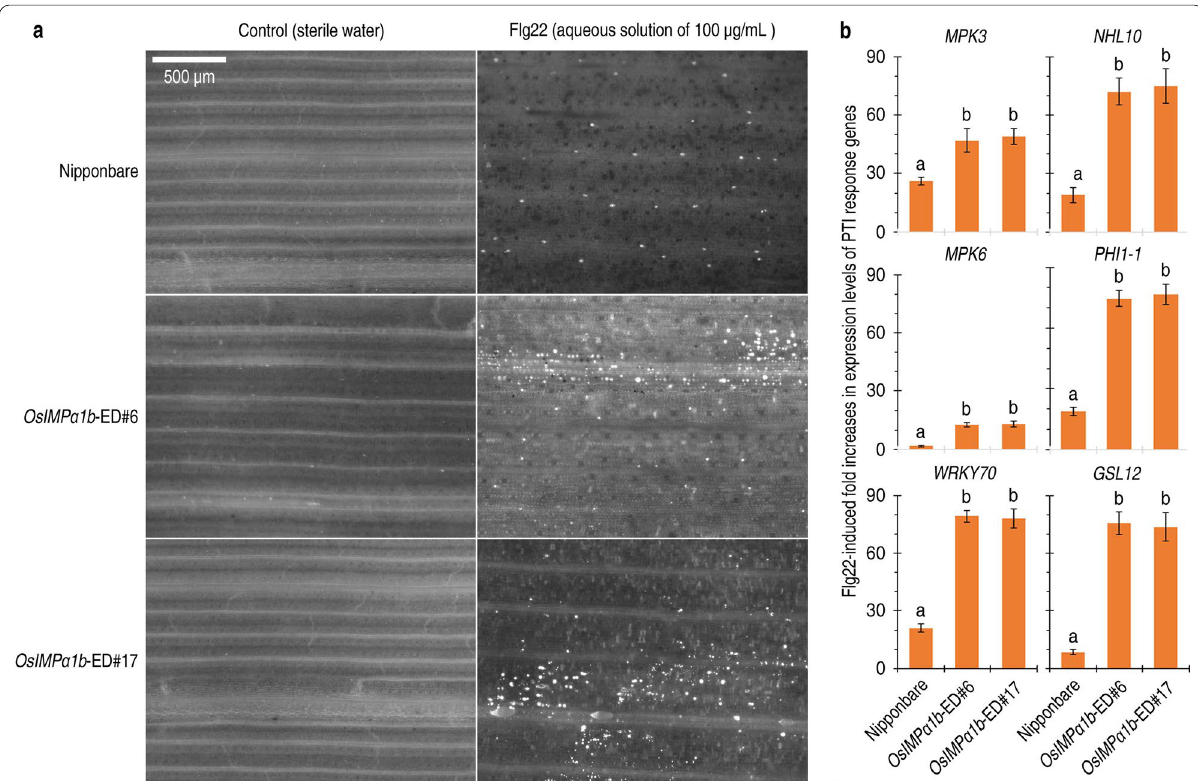
Fig. 8 Essential pattern-triggered immunity (PTI) responses occurred in leaves of the WT and OsIMPα1b -edited plants treated by spraying the tops of the plants with sterile water (control) or an aqueous solution of flg22. a Callose deposition on leaf surfaces of the different plants at 24 h after treatment. Each leaf image is representative of 15 leaves of 3 plants tested in 3 experimental replications. b Flg22-induced fold increases in